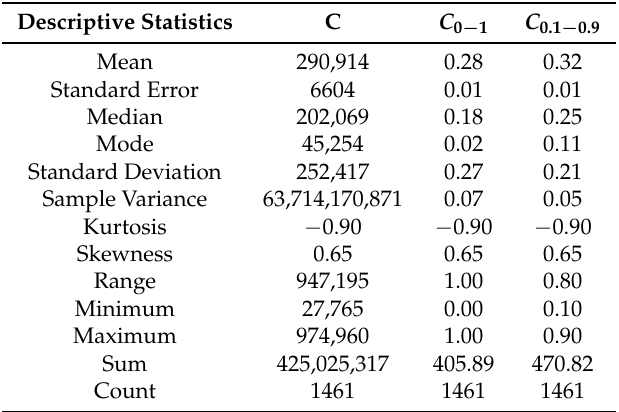
Table 1. Descriptive statistics of consumption and normalized